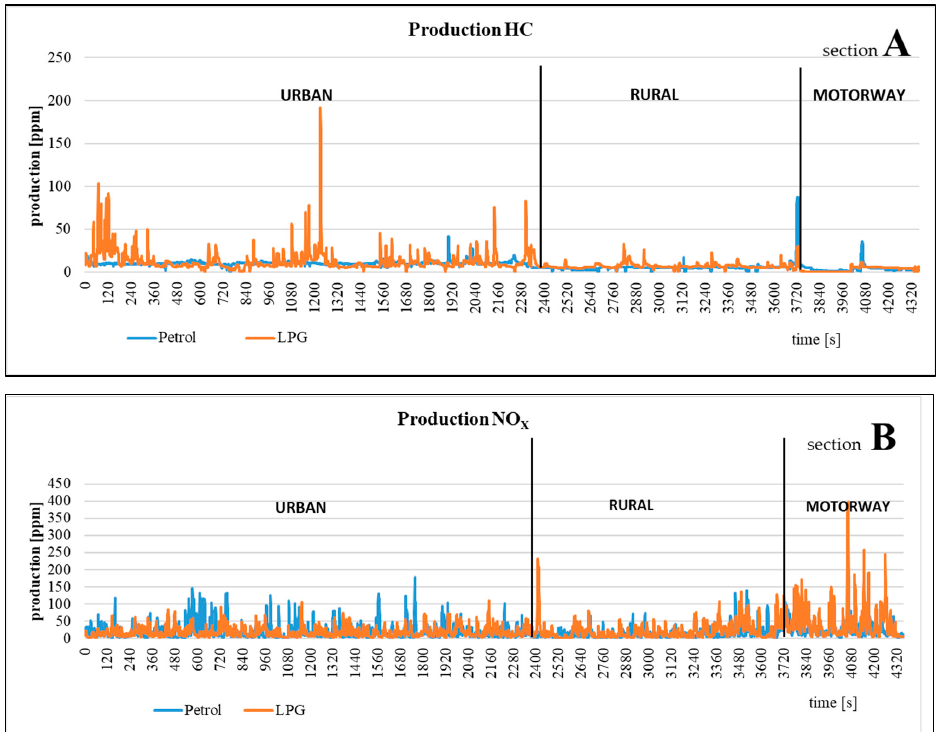
Figure 7. HC ( A ) and NO X ( B ) production process while driving.